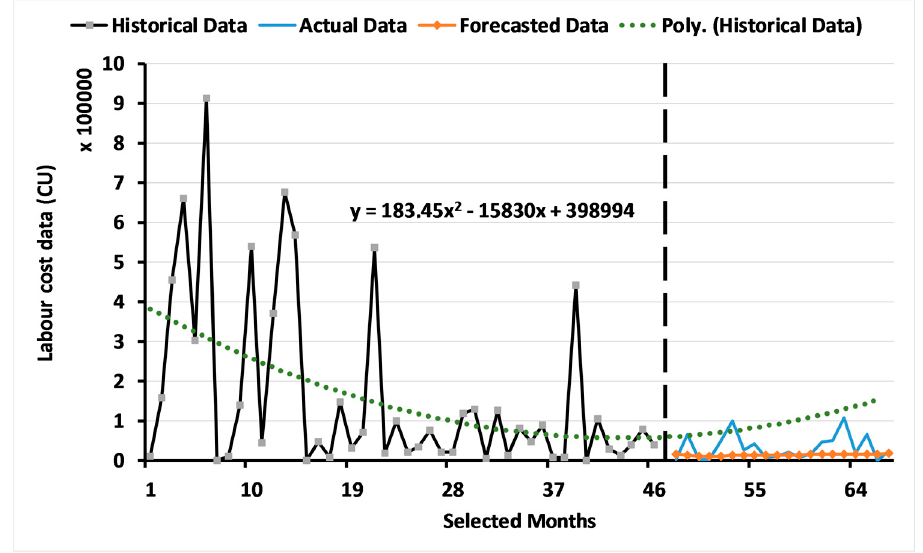
Figure 4. Labour cost data forecasting using the multi ‐ objective GA based on the ARIMA model.